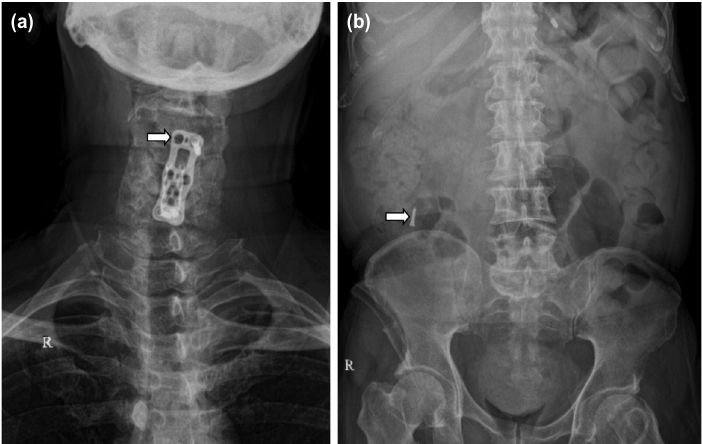
(a) Showing AP radiograph of cervical spine showing missing right sided proximal screw of cervical plate as pointed with white Fig. 2: arrow which had earlier backed out, (b) showing AP abdominal radiograph with migrated screw from cervical spine on right side of abdomen as marked with white arrow.